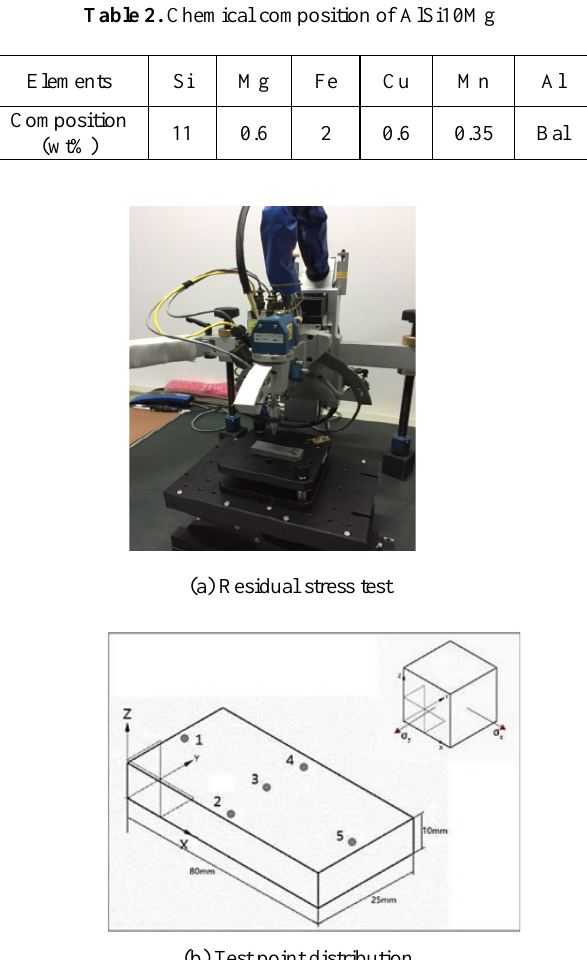
Fig. 1. Test scheme for sample residual stress